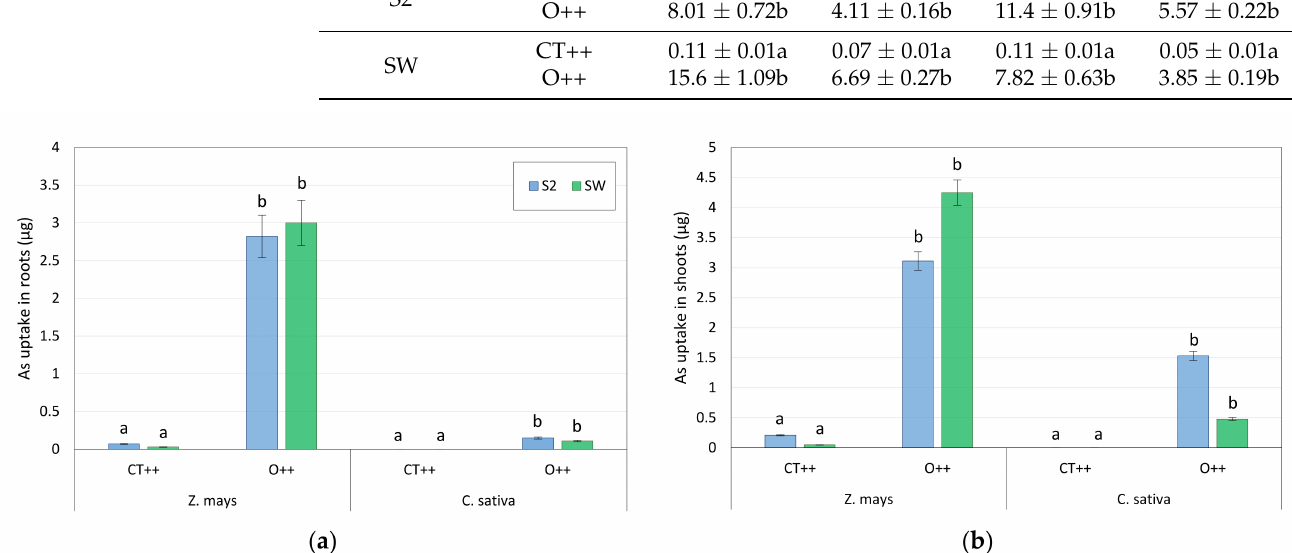
Figure 9. Arsenic total uptake by ( a ) roots and ( b ) shoots of Z. mays and C. sativa grown on soil control (CT) and As-contaminated soil treated with oxalate (O). PGPR bacteria (second set of isolates) were added to all soil samples, as indicated by the “++” sign. The values are the mean of three replicates, and the error bars show the standard deviation. Values with different letters are significantly different at the 5% probability level (Tukey’s